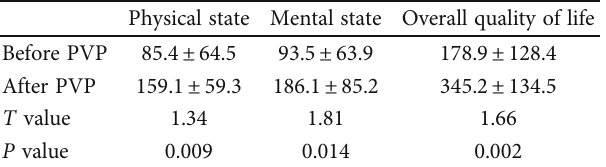
Figure 4: Case 4. Table 1: Quality of life score results before and after